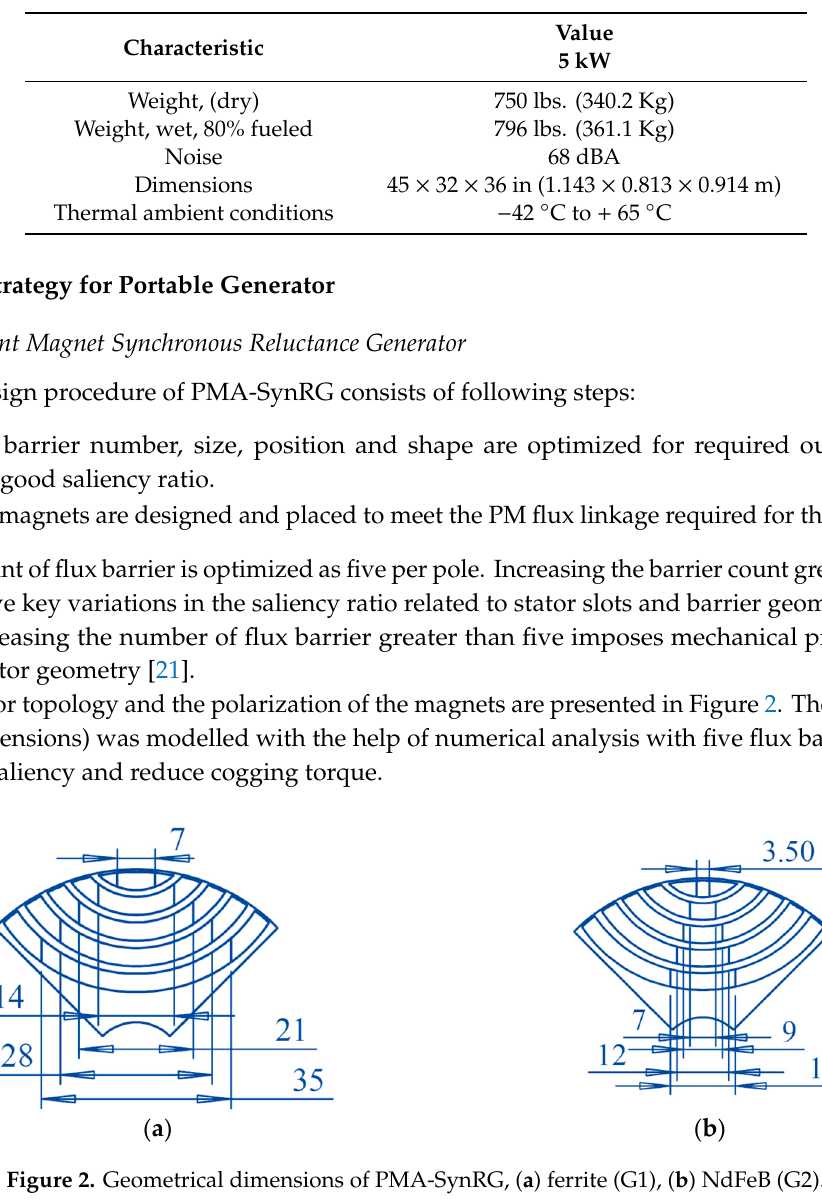
Table 1. As per military standards.